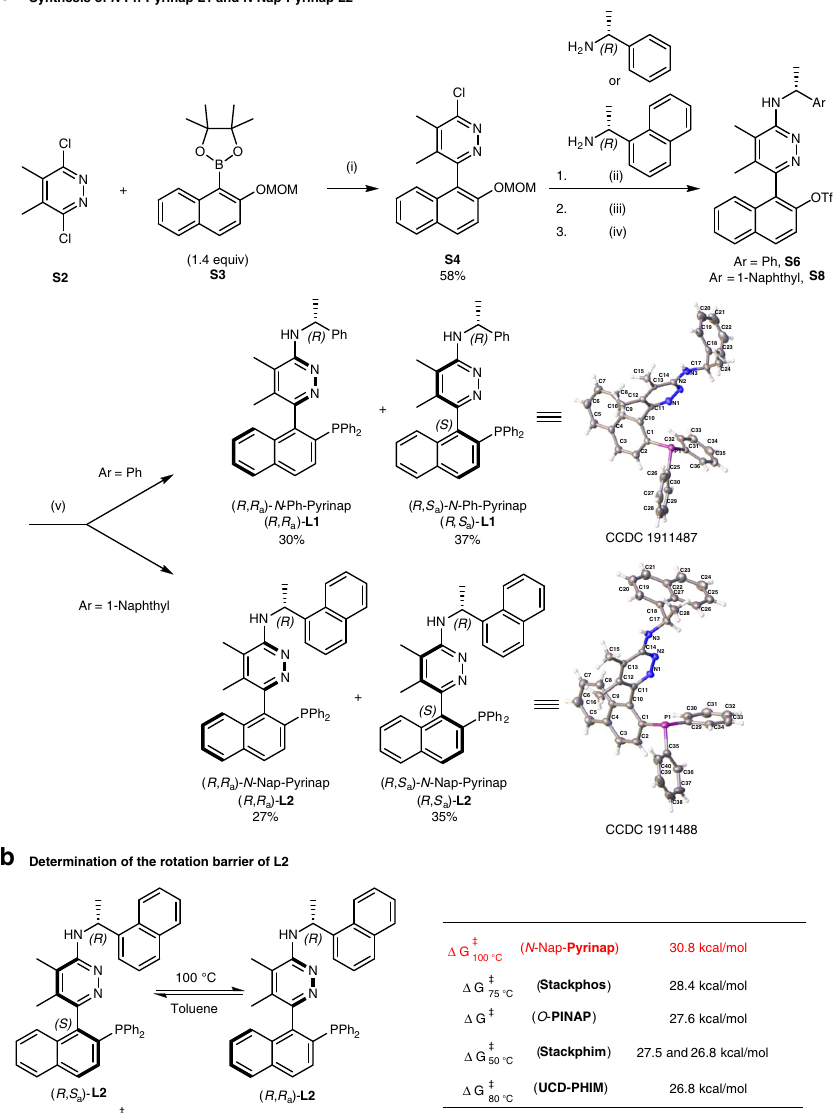
Fig. 2 Synthesis of Pyrinap ligands and determination of rotation barrier between ( R , S a )-L2 and ( R , R a )-L2. Reagents and conditions: (i) Pd(OAc) 2 (5 mol%), PPh 3 (20 mol%), Na 2 CO 3 (2 equiv), DME/H 2 O = 3:1, re fl ux, (58%); (ii) ( R )-1-phenylethyl amine or ( R )-1-(1-naphthyl)ethyl amine (1.3 equiv), Pd (OAc) 2 (5 mol%), rac -Binap (7.5 mol%), Cs 2 CO 3 (1.4 equiv), toluene, re fl ux; (iii) HCl (3 M in MeOH/H 2 O), r.t.; (iv) PhNTf 2 (1.0 equiv), Et 3 N (1.0 equiv), DMAP (10 mol%), DCM, r.t. (for Ar = Ph, 83% yield in step (ii) and 90% yield over 2 steps (iii and iv); for Ar = 1-naphthyl, 86% yield over 2 steps (ii and iii) and 90% yield in step (iv).) (v) NiCl 2 (dppe) (10 mol%), HPPh 2 (2 equiv), DABCO (4 equiv), DMF, 120 °C, 12 h. DME 1,2-dimethoxyethane,